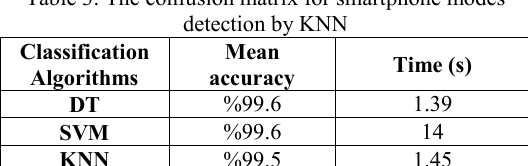
Table 4. Time and accuracy of detection classification algorithms